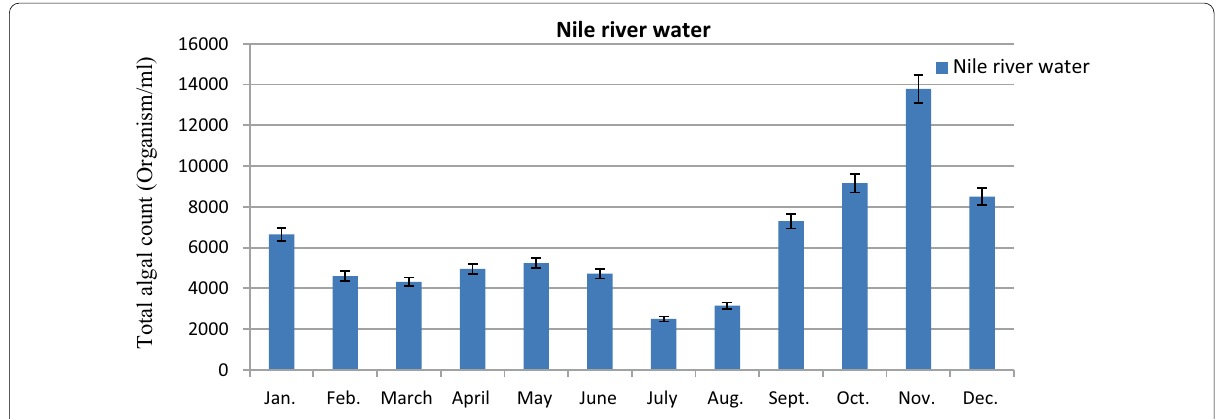
Fig. 1 Total algal count (Organism/ml) in Nile river water samples